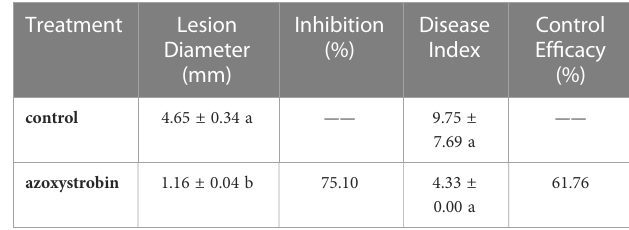
TABLE 3 Field control of tobacco target spot by